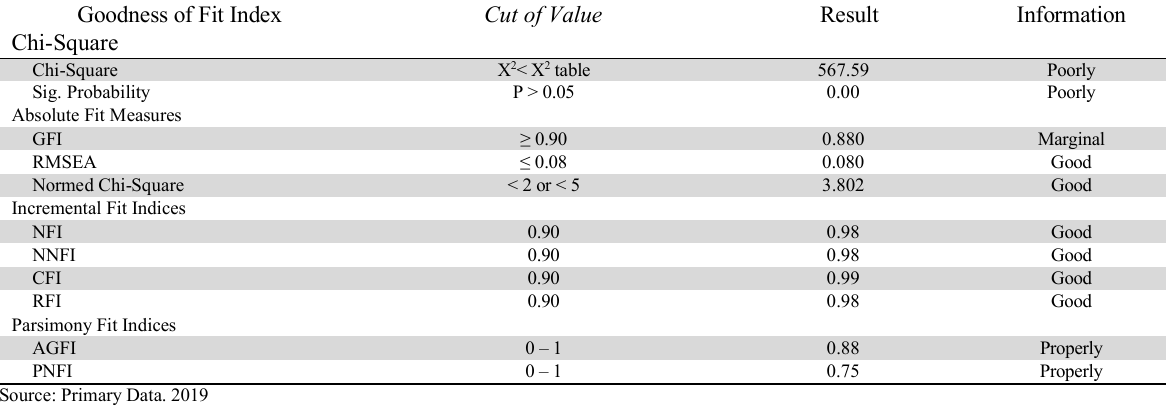
Direct Indirect Coefficient